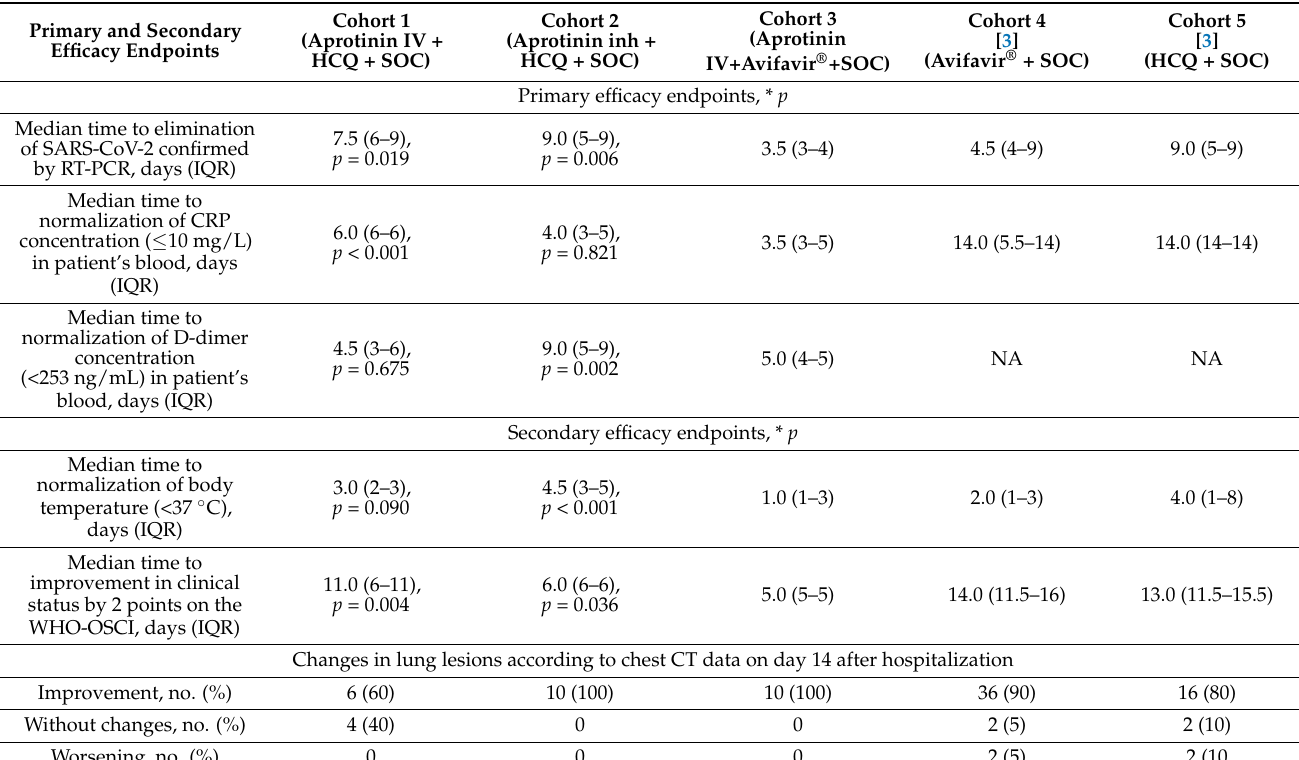
Table 1. Primary and secondary efficacy